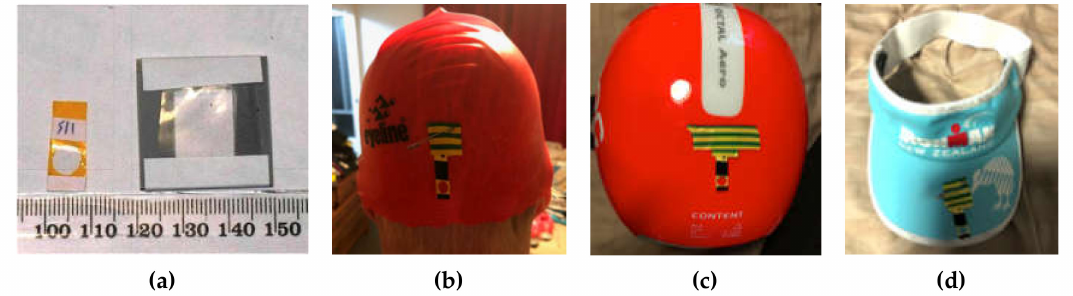
Figure 2. Polysulphone film dosimeters used in this study were adhered to small flexible frames notably smaller than badges used in similar studies ( a ), that were pinned to the swimming cap ( b ), bicycle helmet ( c ) and cap ( d ) of each